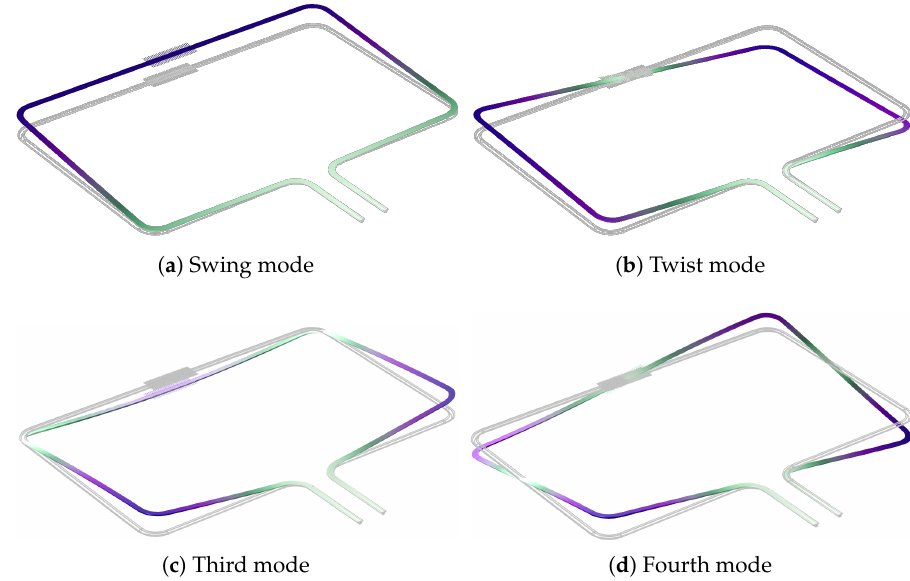
Figure 3. Mode shapes ( a – d ) for the four actuation modes that are used in this paper. The swing mode ( a ) and twist mode ( b ) are usually used for mass flow sensing.